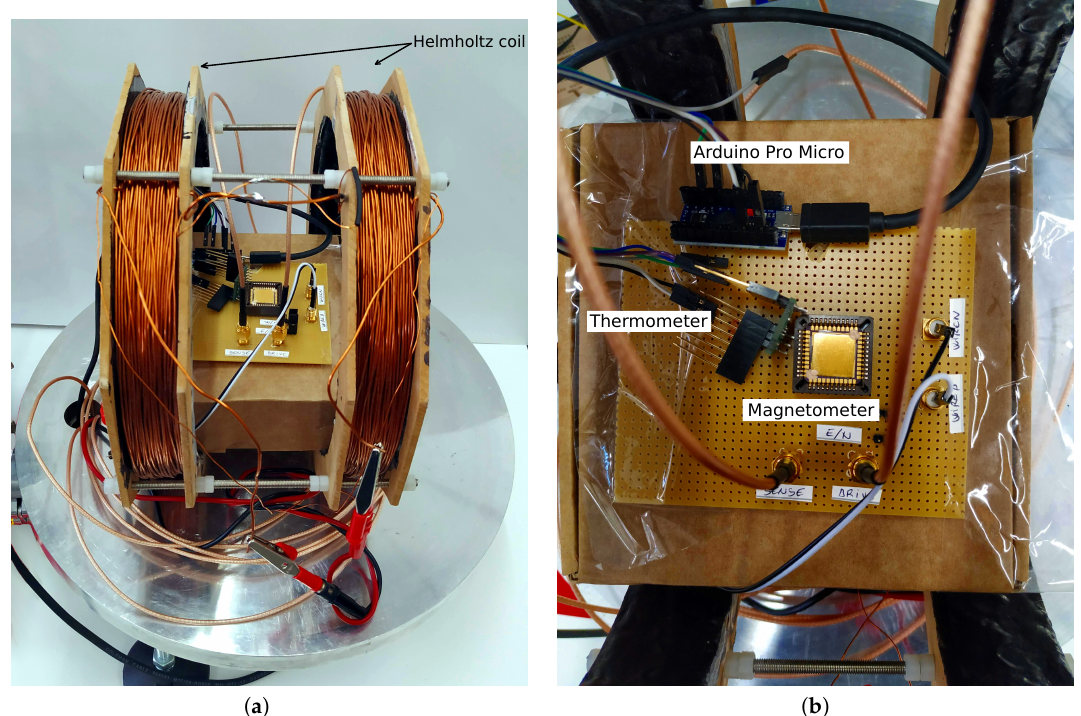
Figure 5. Images of the vacuum chamber setup. In ( a ), a general image of the setup right before placing the glass bell jar. The device chip is in the board socket, inside the Helmholtz coil. In ( b ), the board placed inside the coil is shown. The reference temperature sensor can be seen placed very close to the device, whose data is sent to a computer by an Arduino Pro Micro microcontroller